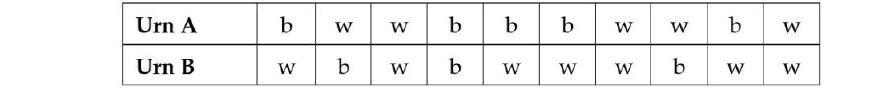
Figure 1. Questionnaire given to prospective teachers. In Task 1, adapted from Sánchez and Valdez [25], the participants were asked to estimate the number of white and black balls in the urn, using the result of 1000 extractions. The probability of drawing a ball of each colour in the urns will be given by w/10 and b/10, where w is the number of white balls, b the number of black balls, with w + b = 10. Since the composition of the urns is unknown, in this first step, the probability of each colour must be estimated from the relative frequency of results in the 1000 extractions.